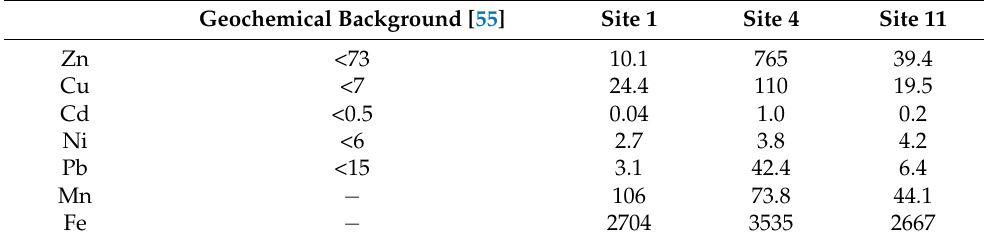
Table 2. Mean metal contents and geochemical background [mg/kg] in bottom